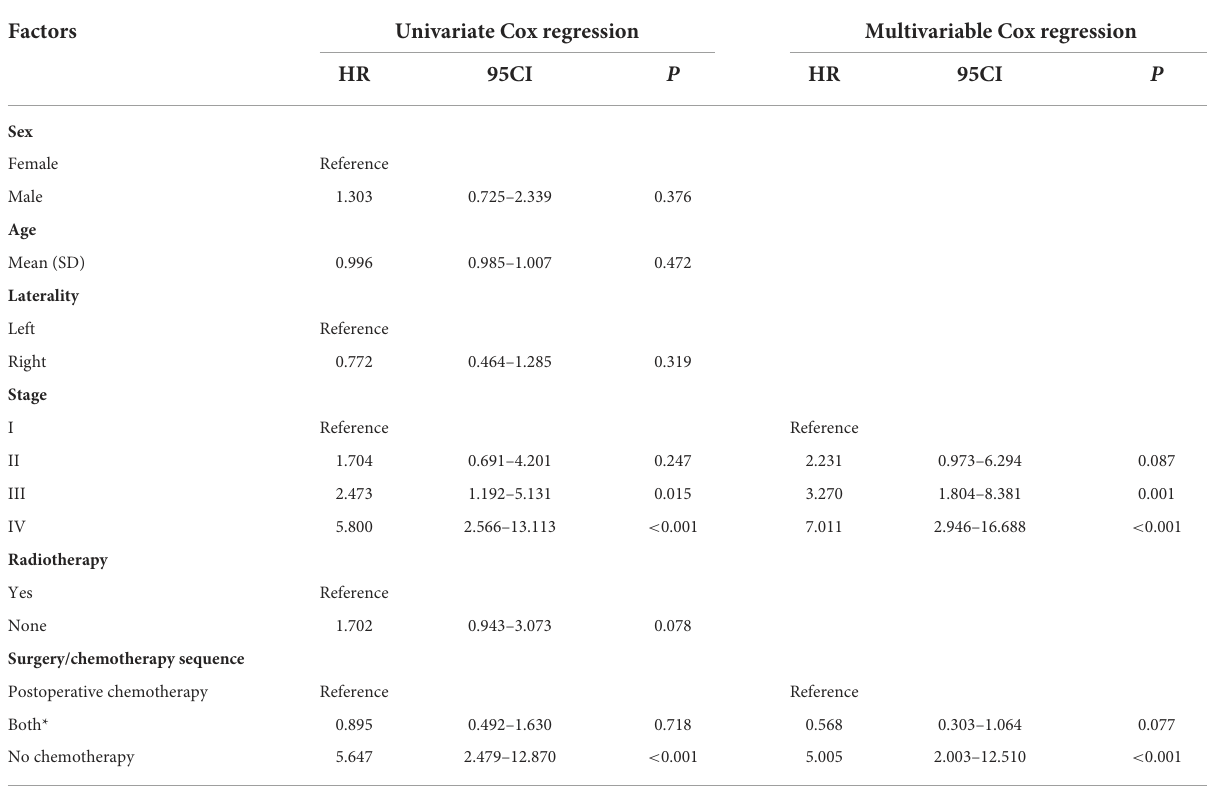
TABLE 5 Univariate and multivariate Cox regression in relapse